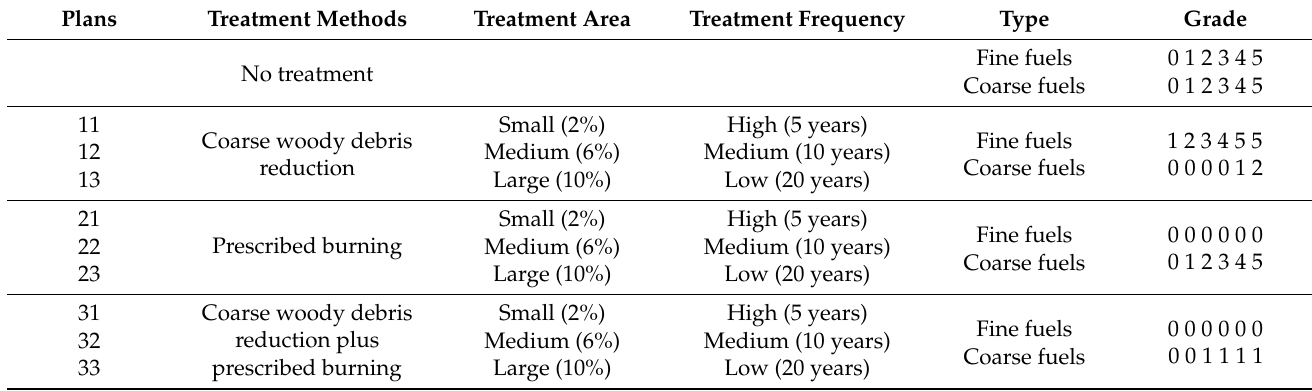
Table 3. Fuel treatment plans and parameters.